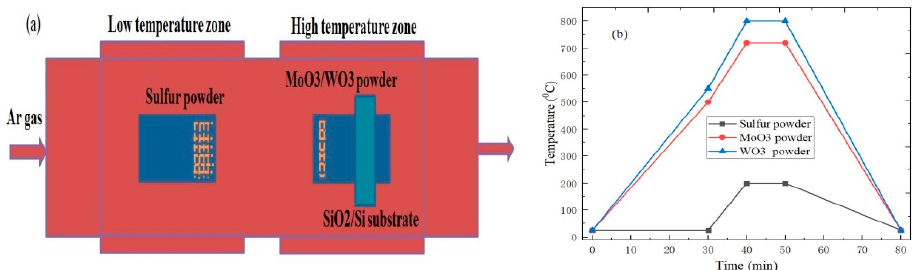
Figure 1. ( a ) Schematic diagram of MoS 2 or WS 2 materials growth experiment by atmospheric pressure chemical vapor deposition (APCVD); ( b ) The temperature change diagram of MoS 2 or WS 2 materials experiment process by APCVD.